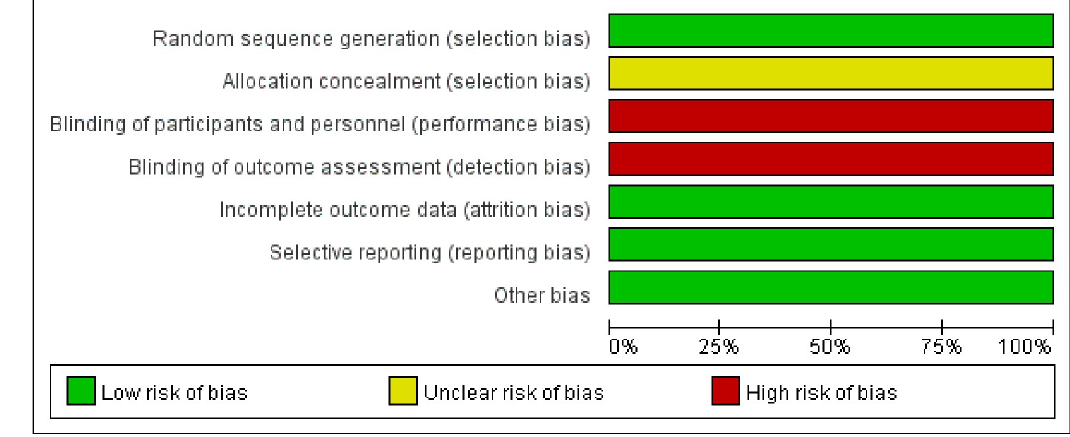
Fig 2. Risk of bias.